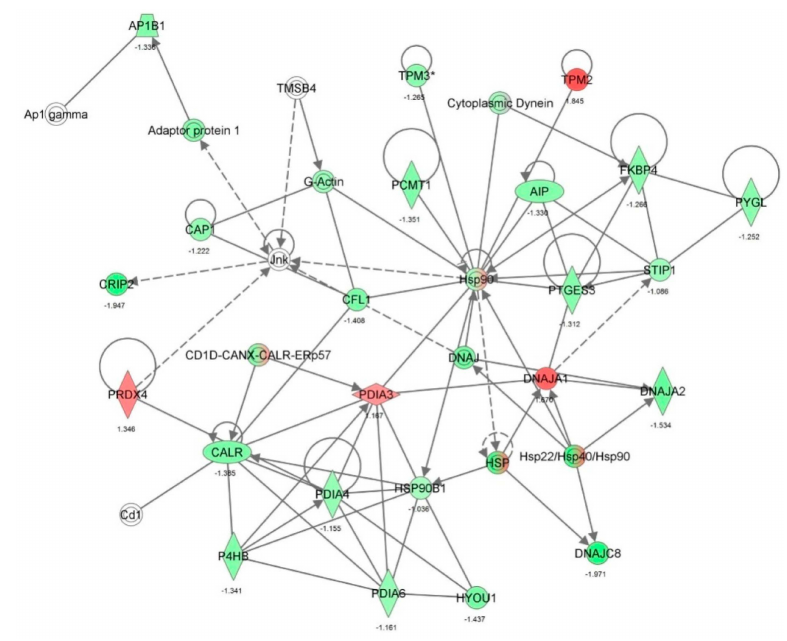
Figure 12. Vancomycin regulated post-translational modification, protein folding, and drug metabolism. Red indicates an up-regulation; green indicates a down-regulation. The intensity of green and red colors indicates the degree of down- or up-regulation. Solid arrow indicates direct interaction and dashed arrow indicates indirect interaction.